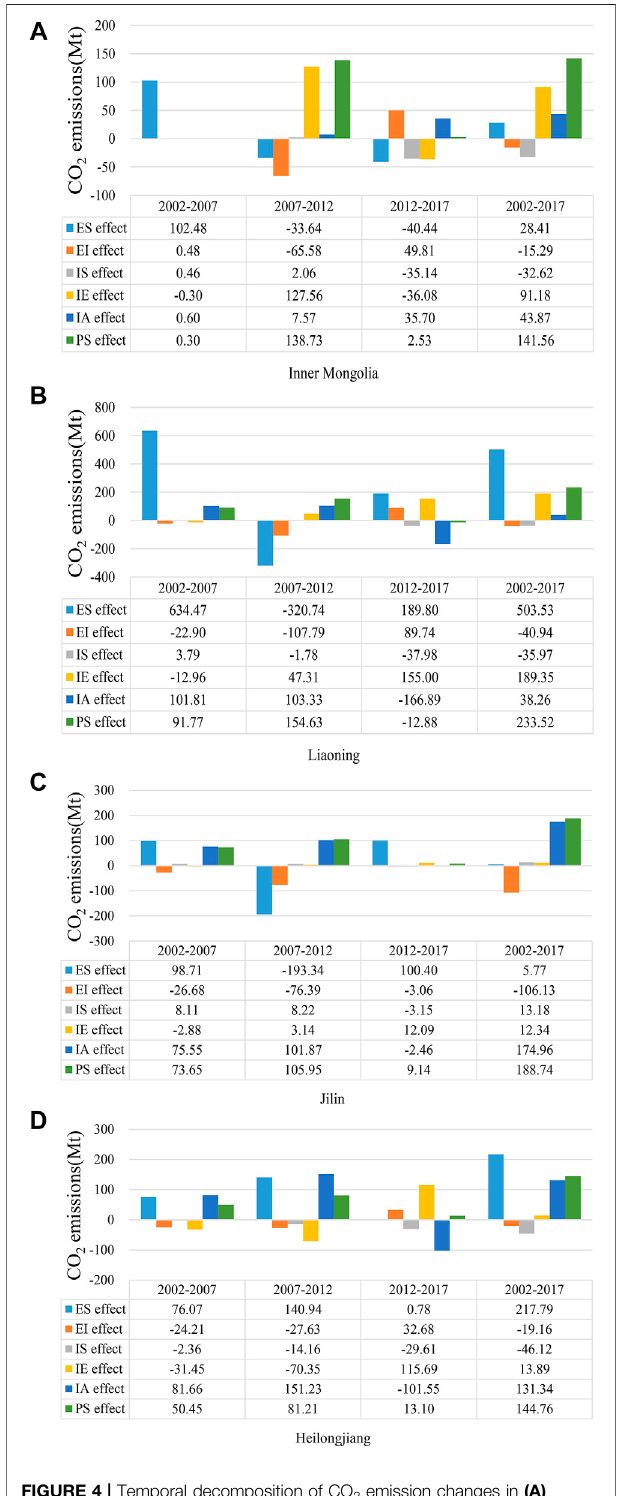
FIGURE 4 | Temporal decomposition of CO 2 emission changes in (A) (Inner Mongolia), (B) (Liaoning), (C) (Jilin) and (D) (Heilongjiang).